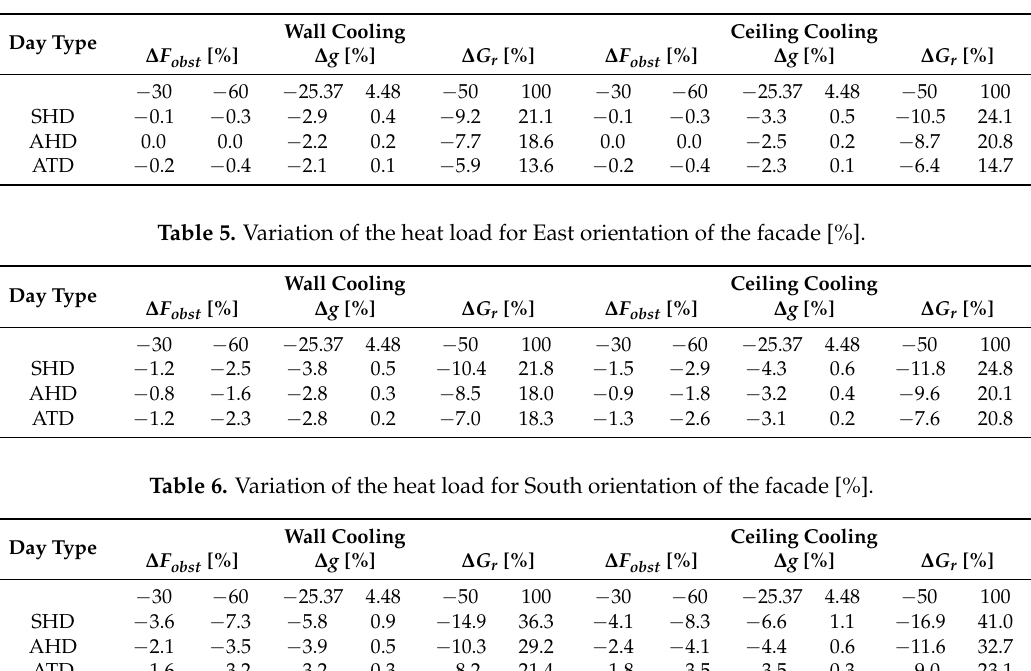
Table 4. Variation of the heat load for North orientation of the facade [%].